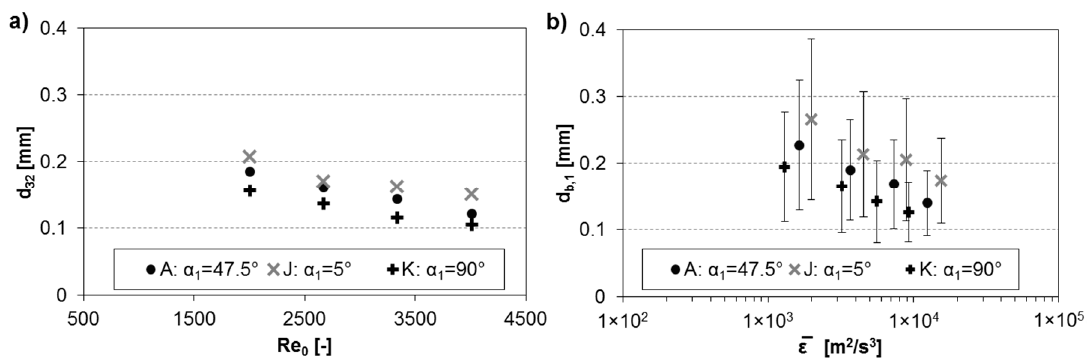
Figure 13. Influence of diffusor angle α 1 on bubble breakup behind micronozzles. Geometrical nozzle parameter besides α 1 are held constant for investigated inlay elements: d − 1 = 1 mm, α − 1 = 8 ◦ , d 0 = 0.5 mm, l 0 = 2.5 mm, d 1 = 1.25 mm. Diffusor angle α 1 possessed varied values, i.e., nozzle inlay J: α 1 = 5 ◦ , nozzle inlay A: α 1 = 47.5 ◦ , and nozzle inlay K: α 1 = 90 ◦ . Volumetric flow rates of (cid:1848)(cid:4662) (cid:3047)(cid:3042)(cid:3047) = 60, 80, 100, and 120 mL/min are employed for each nozzle inlay. ( a ) Obtained Sauter diameter of broken up bubbles plotted over Renumber in smallest cross section for different (cid:2009) (cid:2869) ; ( b ) mean bubble diameter of refined dispersed phase plotted over mean energy dissipation rate for various (cid:2009) (cid:2869) .